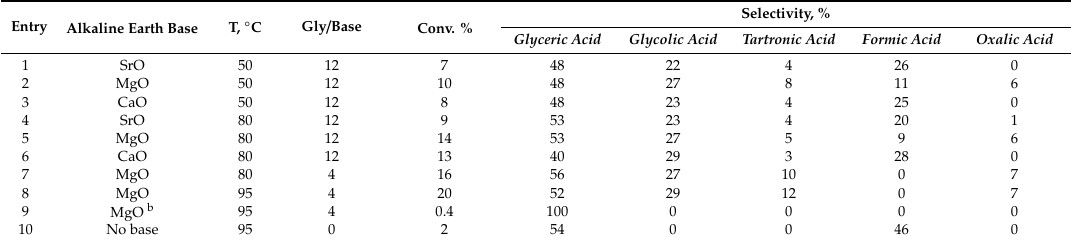
Table 3. Effect of an alkaline earth base and reaction temperature on glycerol oxidation on Au/La ₂ O ₃ /TiO ₂ a . Entry AlkalineEarthBase T, ◦ C Gly / Base Conv. %